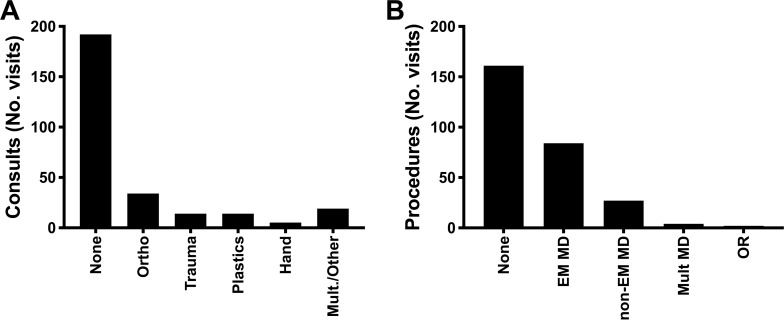
Most trauma-related complaints were adequately managed in the emergency department by emergency medicine physicians.Specialist consultations (A) and procedures (B) required for 278 trauma-related patient encounters for incarcerated patients presenting to a tertiary care, academic emergency department between January 2012 and December 2014 are shown in the number of patient encounters (No. visits). EM, emergency medicine; MD, medical doctor; Mult, multiple; No., number; OR, operating room; Ortho, orthopedics.